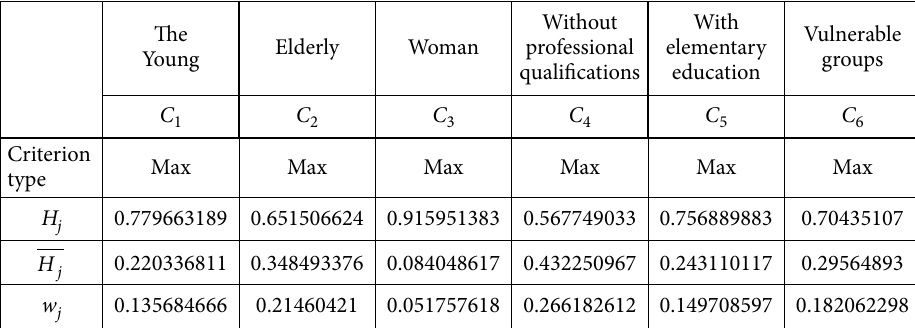
Table 4. Entropy based weights (source: authors’